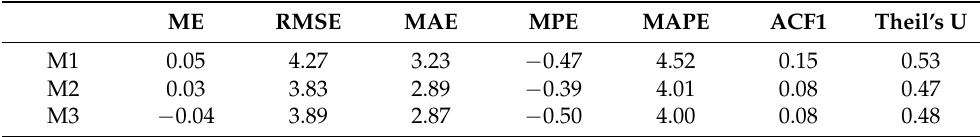
Table 7. Psychologist’s hybrid model accuracy measures.